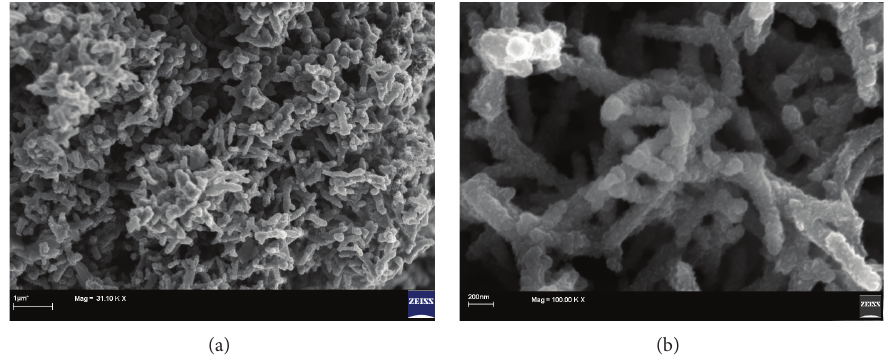
Figure 5: SEM image of PANI-ES with increase of (a) 31,000 and (b) 100,000 times.